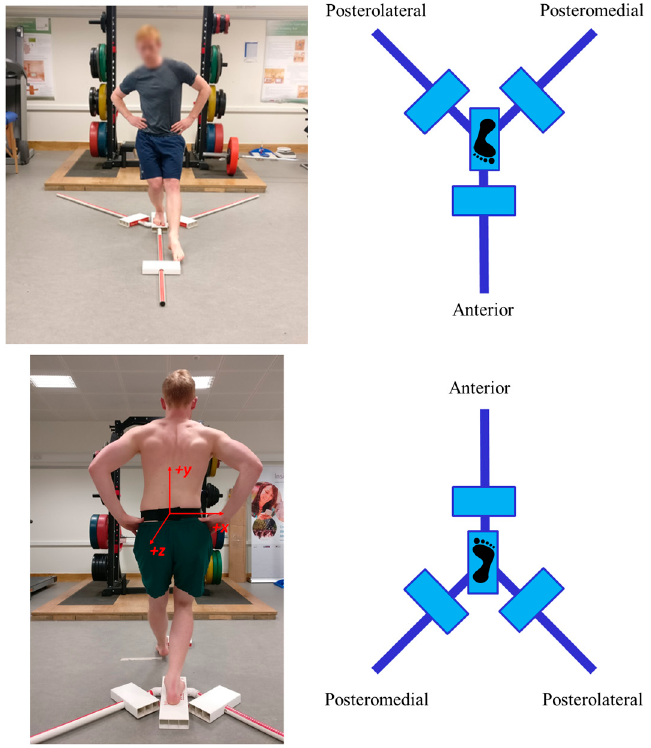
Figure 1. A YBT excursion in operation, a diagram of the directions [3], and the lumbar inertial sensor orientation and location.